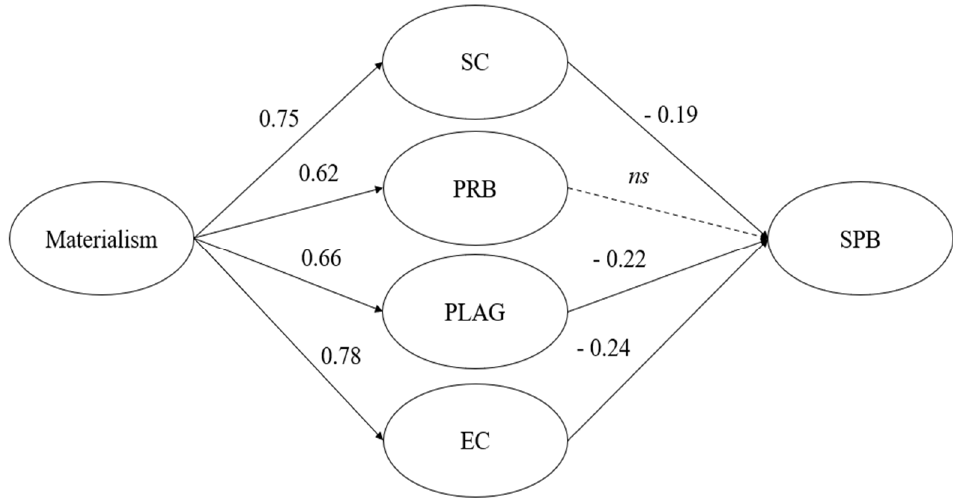
Figure 2. Results of the nomological analysis. Note: p < 0.05; ns: non-significant.